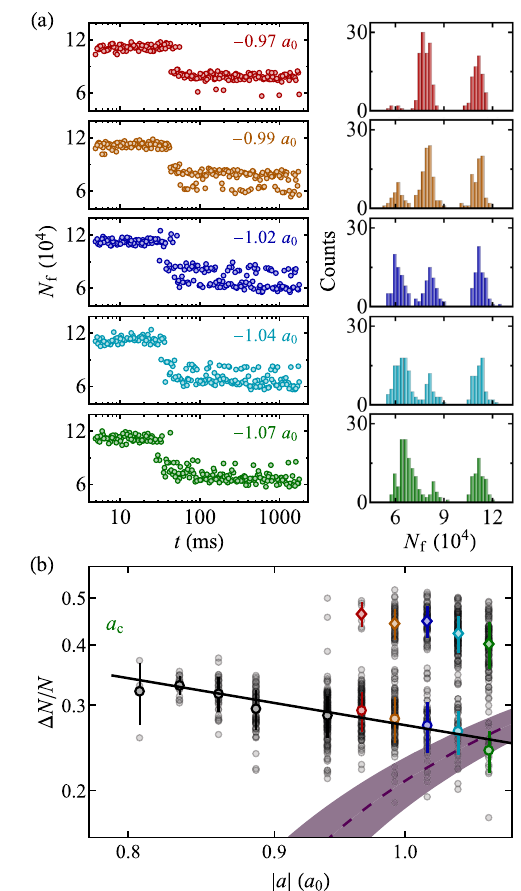
(1975).FIG. 6. Transition from one to two collapse events. (a) Atom number versus t for L ¼ 30 μ m, initial N ¼ 11 . 4 × 10 4 , and − 0 . 79 a various closely spaced a values; here, a 0 . On the c ¼ right, we show histograms of N values. For t > t , we see two f c clearly resolved N branches, corresponding to one (upper f branch) and two (lower branch) collapse events. The probability of a double collapse gradually increases with j a j . (b) Fractional atom loss versus j a j on a log-log plot. The transparent black circles show the raw data. The colored circles and diamonds show, respectively, the average values for the single- and double- collapse events. The color code is the same as in (a). The error bars show the standard deviations. The purple dashed line shows the BEC stability criterion as in Fig. 4(b), and the shading shows its uncertainty. The solid black line shows the (single-event) weak-collapse scaling, Δ N=N ∝ 1 = j a j